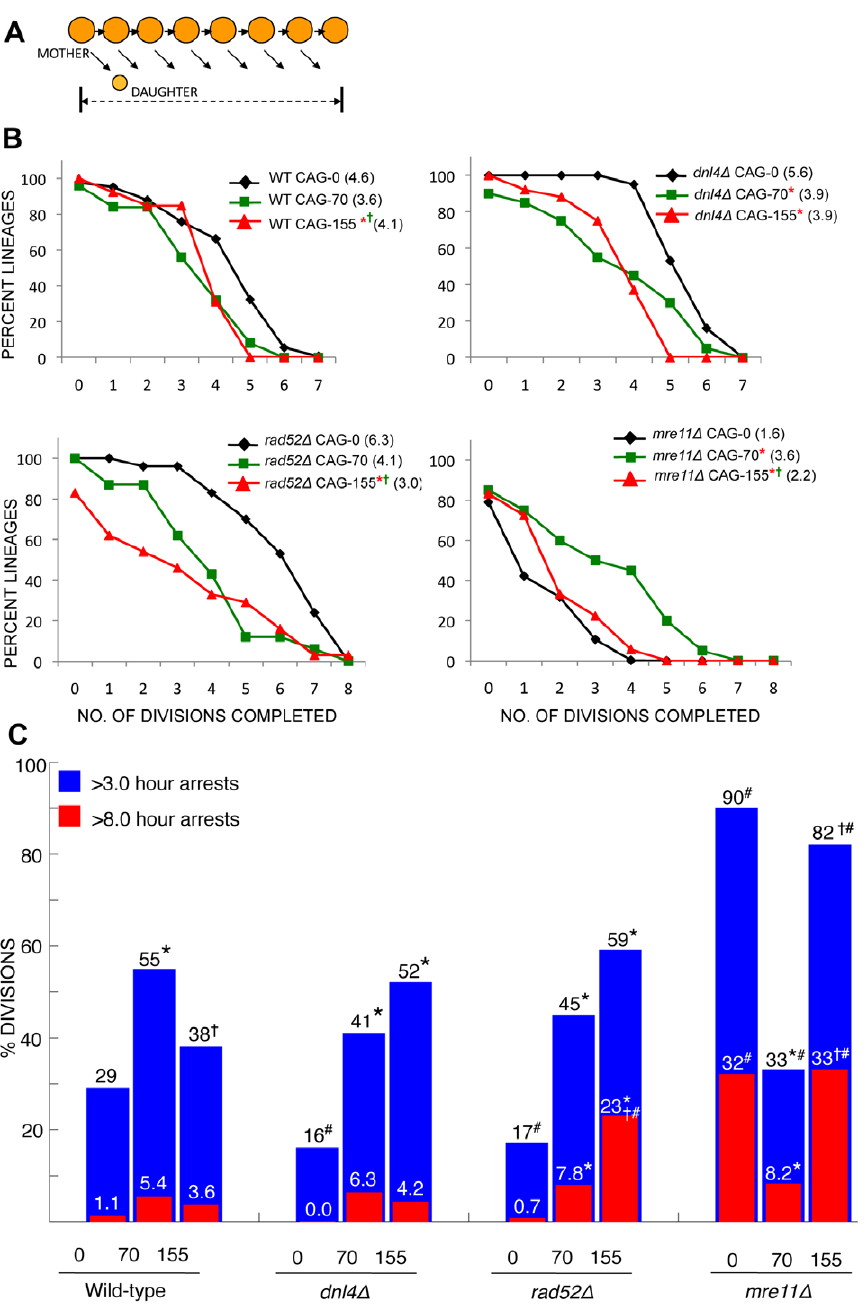
Figure 2. Single cell pedigree analysis of CAG/CTG repeat-containing cells. (A) Pedigree analysis scheme: a yeast mother cell was micromanipulated onto solid media, and daughter cells separated and moved away upon each cell division, so that the duration and characteristics of each cell division could be monitored. The mother cell lineage was followed so that daughter cell growth delays were not a factor. The dotted arrow represents one lineage of 7 divisions. (B) Doubling efficiency curves were generated from an average of 30 lineages (range 15–41) per strain, each followed for , 18 hours. Strain name followed by mean number of doublings indicated in brackets. Comparisons are done on the distributions within a genotype, either between the CAG-0 control and CAG-70 or CAG-155 strains (*), or between CAG-70 and CAG-155 strains ( { ); Symbols denote p , 0.05 using a Wilcoxon’s sum-rank test. (C) Graphical representation of frequency of arrest divisions (computed out of total # of divisions) that have lasted . 3.0 hours (in blue) or . 8.0 hours (in red); the . 8 hr values are a subset of the . 3 hr values, and therefore overlaid on the . 3 hr bars (not stacked). Statistically significant comparisons to CAG-0 (*p , 0.05) or between CAG-70 and CAG-155 strains ( { p , 0.05) within genotype are indicated; statistics performed by logistic regression analysis. Comparison to WT of the same tract length ( # , p , 0.01) by Fisher’s exact